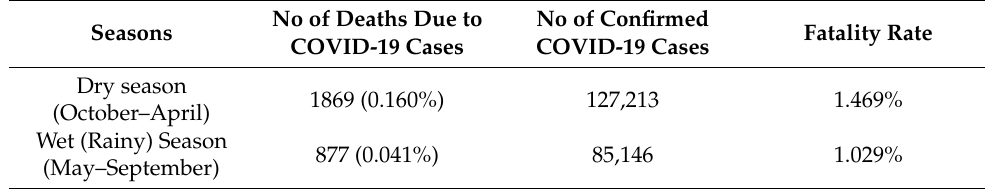
Table 3. Fatality Rate of COVID-19 during the Dry and Wet Seasons in